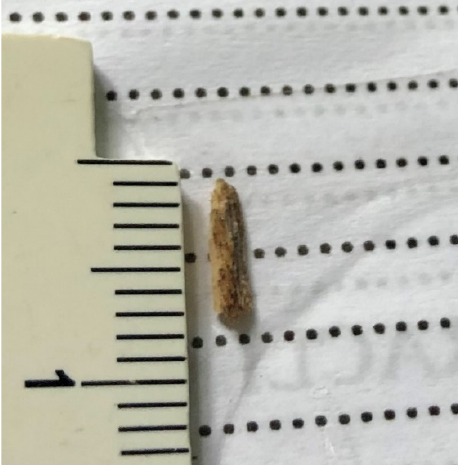
Figure 2. Large IOFB ( 7 mm). IOFB=Intraocular foreign body.